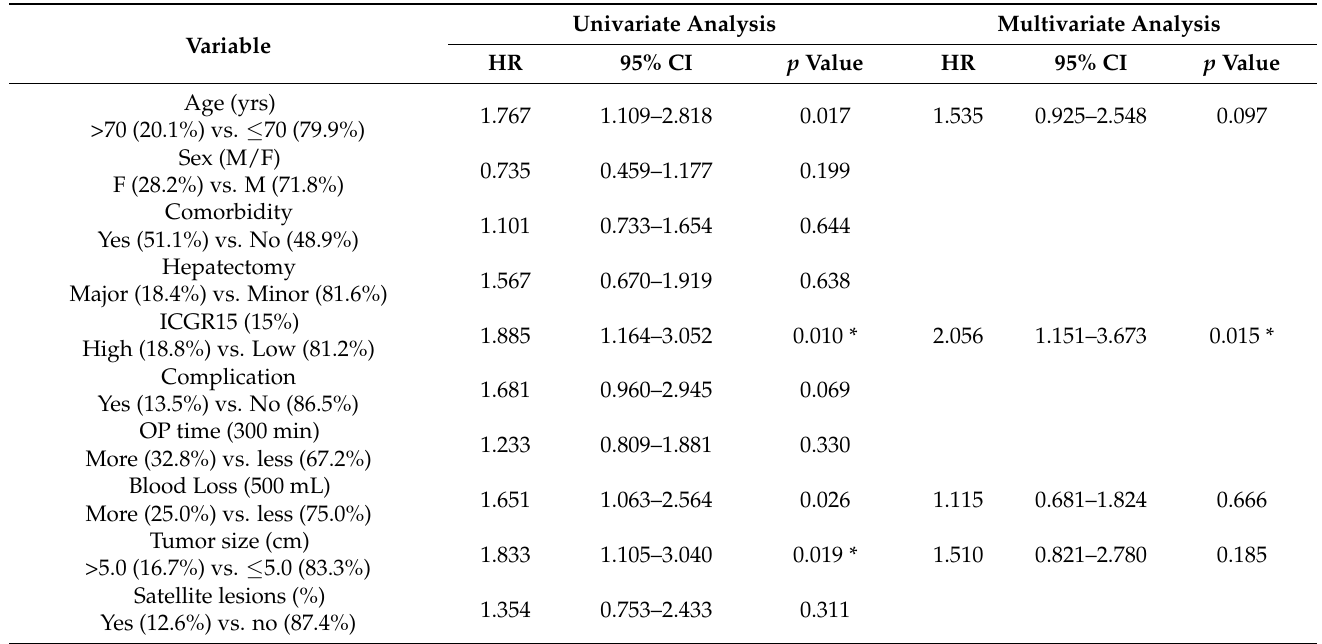
Table 2. Clinicopathologic data and VETC expression of 174 HCC patients in univariate and multi- variate regression analysis.